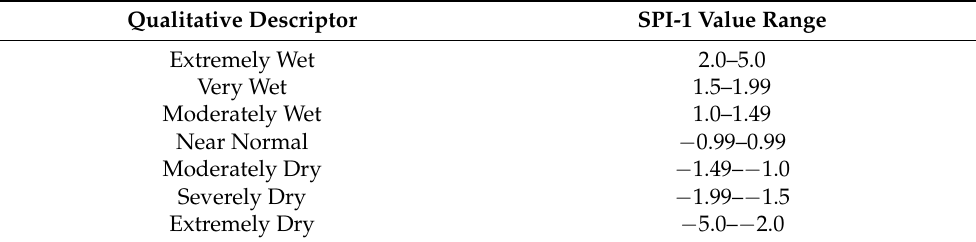
Table 2. Qualitative Descriptors for SPI-1 Values adapted from